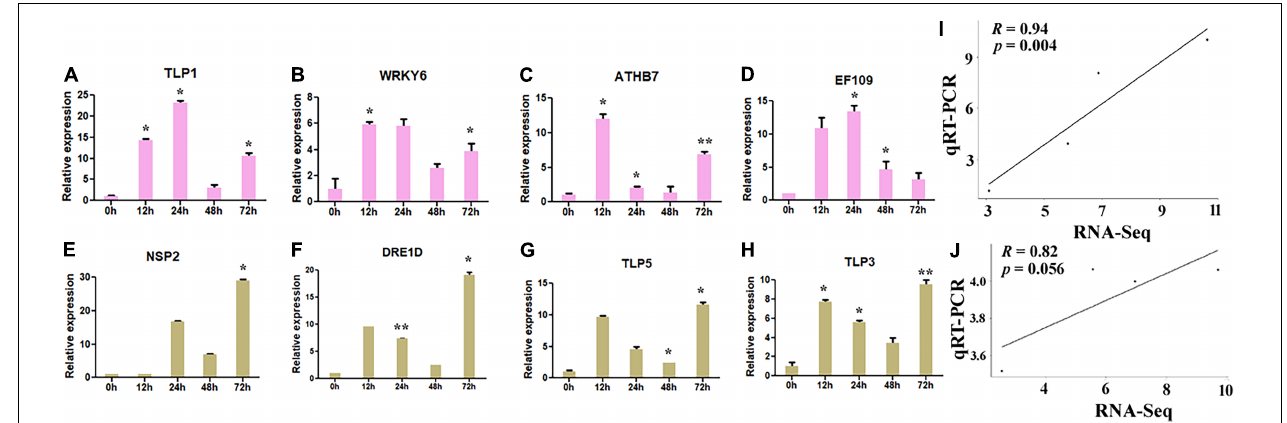
FIGURE 9 | The expression pattern of key hub genes in G. hirsutum . qRT-PCR expression pattern of four putative genes in normal (0 h), 12, 24, 48, and 72 h of salt (300 MM) (A–D) and drought (20% PEG solutions PEG8000) stress (E–H) in cotton. Ubiquitin was used as the loading control. Three biological replicates were used for each experiment. The statistical analysis was performed, using two-tailed Student’s t -test. The data are plotted as means ± SD . The error bars represent standard deviations. (I,J) Correlation analysis against the expression values of qRT-PCR and RNA-Seq data in drought and salt stress conditions. The R represents the Pearson correlation coefficient, respectively. Graph showing a significant positive correlation between qRT-PCR and RNA-Seq data values.